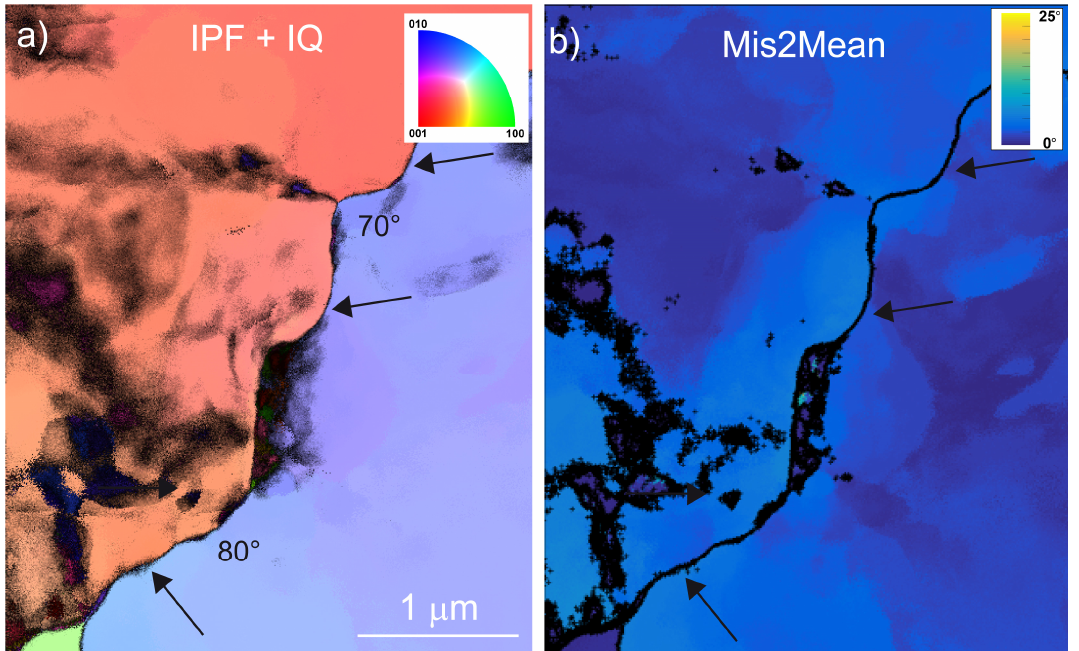
Figure 6. For70B GB. ( a ) IPF corresponding to the direction perpendicular to the plane of view superimposed with the IQ (Equation (1)); color code inserted ( Pnma ). The GB arrow in black has a misorientation of 70 ◦ –80 ◦ . ( b ) Mis2Mean map corresponding to ( a ), up to 25 ◦ .